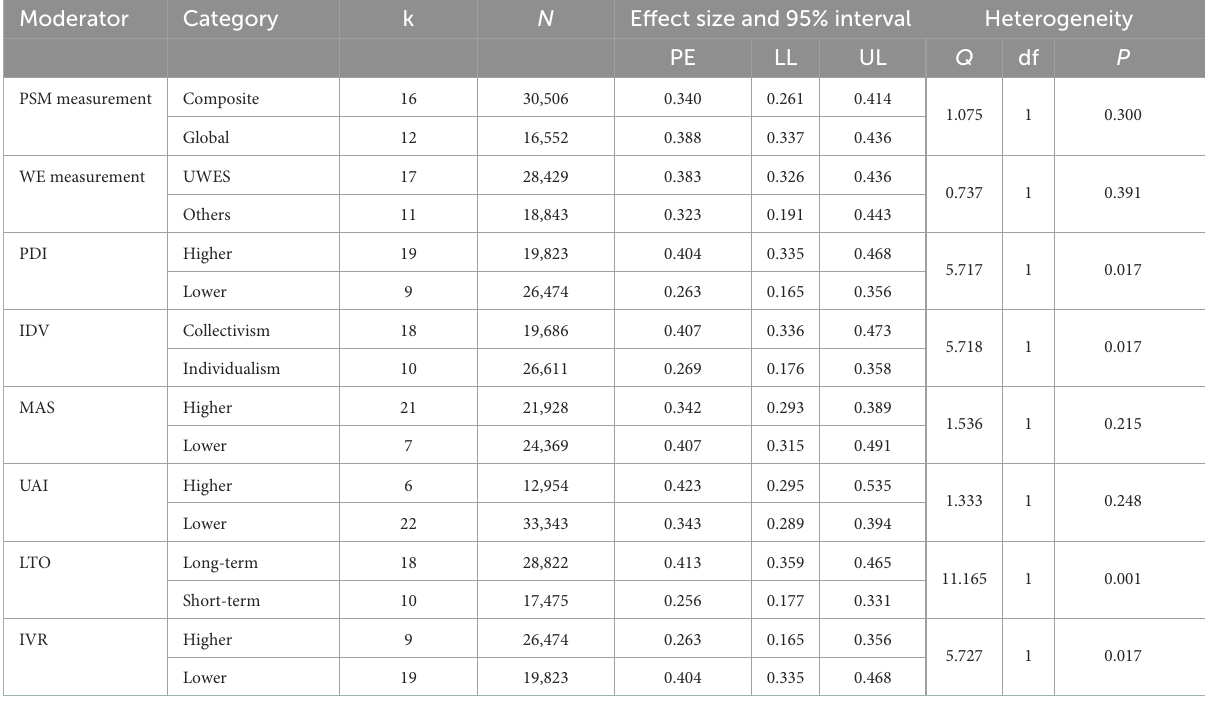
TABLE 4 Results of the test for moderating effects (this table reported the results of the moderating effect tests for the measurement instruments and cultural dimensions). Moderator